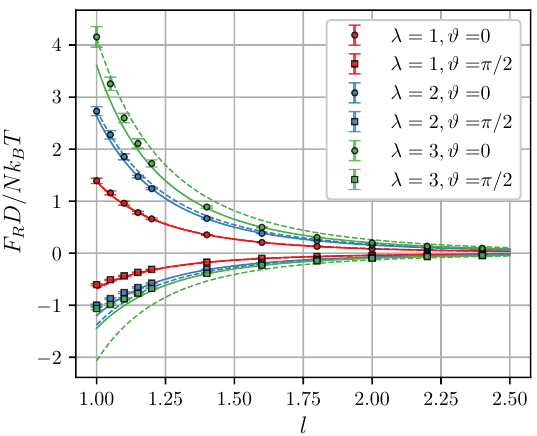
Figure 9. Magnetic central force per core as a function of the intercluster separation at ξ = 8 and ϕ = 0.3. Different colors correspond to different λ (see legend). Symbols are simulation results for N = 100, circles correspond to the “head-to-tail” configuration ( ϑ = 0), and squares correspond to the “side-by-side” configuration ( ϑ = π /2). Solid curves are corresponding MDM predictions [Equations (23), (29)–(32)], dashed curves are from LDM [Equation (27)].